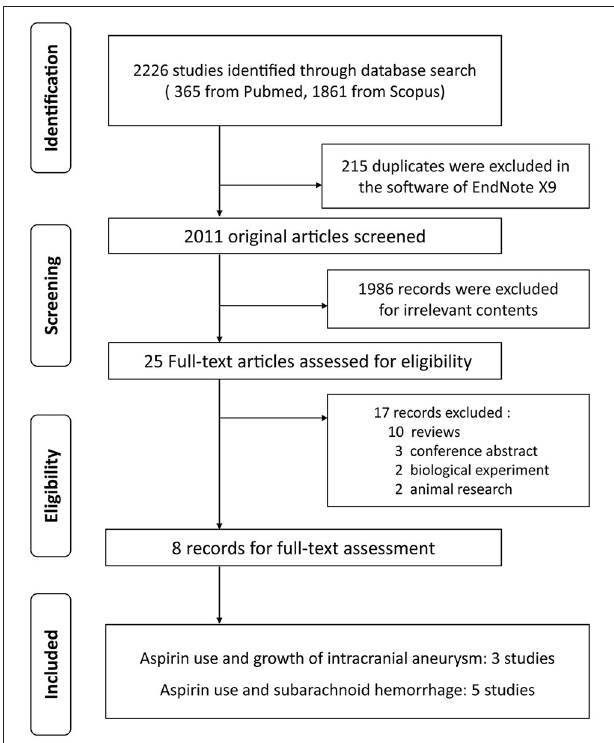
FIGURE 1 | Study screening